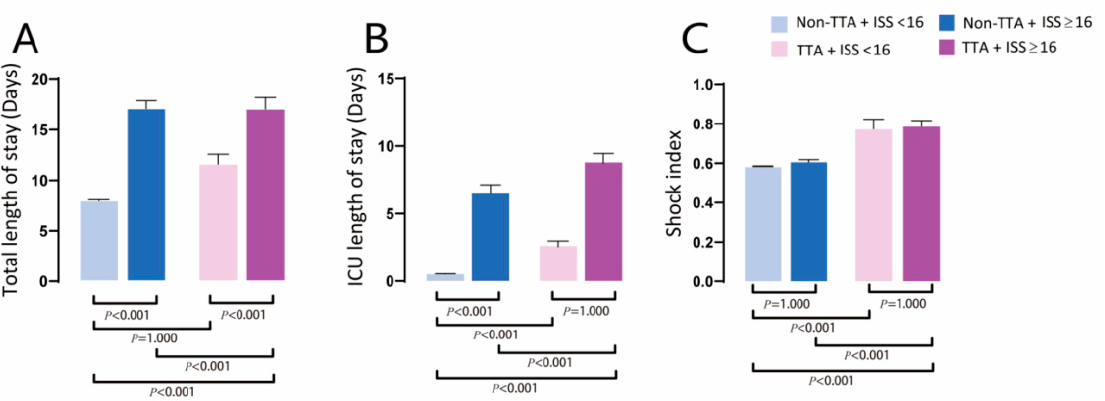
Figure 3. Comparison of ( A ) total LOS, ( B ) ICU LOS, and ( C ) shock index in trauma team activation (TTA) and major trauma (ISS > 16) groups.